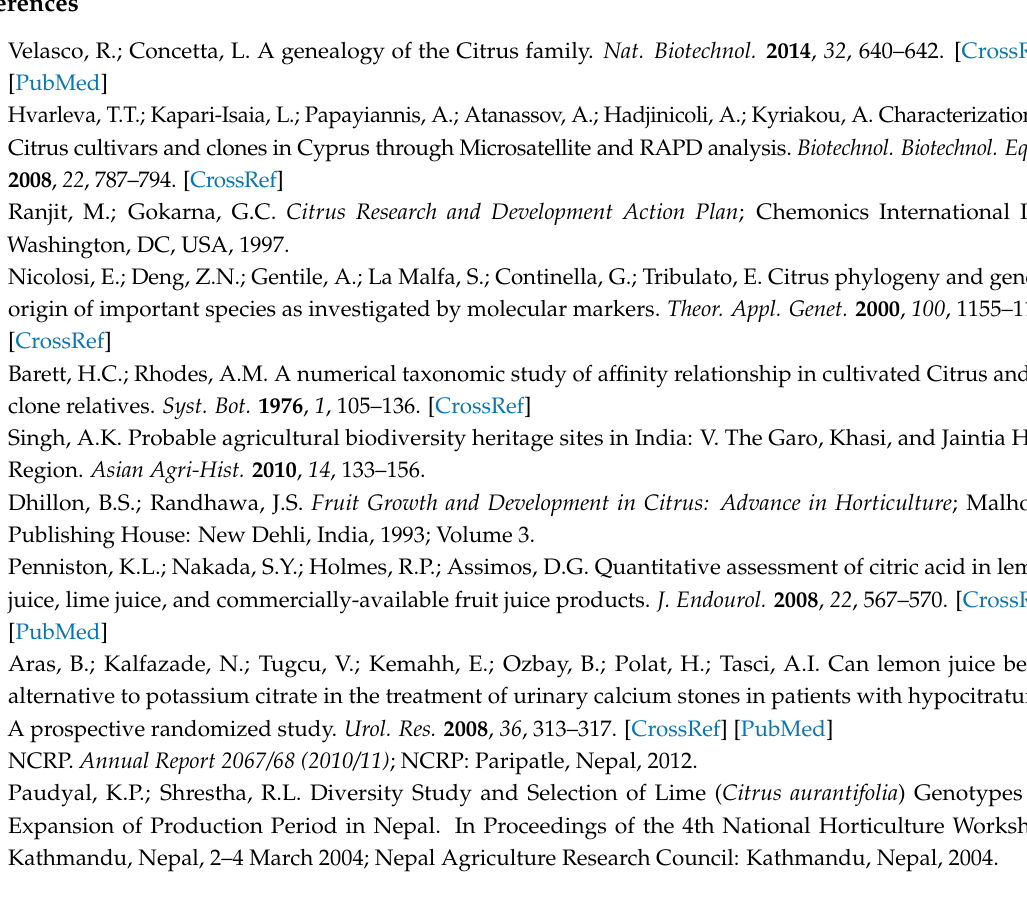
Table S1: ISSR primer details, Total Number of amplified Bands (TNB), Number of Polymorphic Bands (NPB), Percent Polymorphism (PP), amplicon size range, Polymorphic Information Content (PIC), Band Informativeness (I B ) and Resolving power (R P ) computed for different ISSR primers used to generate ISSR profiles in 60 Citrus aurantifolia (Acid lime) accessions; Table S2: Analysis of Molecular Variance (AMOVA) for 60 Acid lime accessions from three agro-ecological regions; Table S3: Correlation Coefficient values generated from Mantel test of original similarity matrices; Table S4: Consensus Fork Index (CI C ) values generated for the UPGMA based phenogram using different similarity coefficients; Table S5: Cophenetic correlation coefficients value (r) obtained for different similarity matrices viz . Simple Matching, Jaccard’s and Dice; Table S6: Percentage genetic similarities observed within and between three agro-ecological zones for various Acid lime samples based on Dice similarity matrix generated from ISSR profile; Table S7: Genetic variation observed for C. aurantifolia samples representing different agro-ecological zones as revealed by POPGENE ver. 1.32; Table S8: Acid lime accessions belonging to two major and three minor clusters of UPGMA